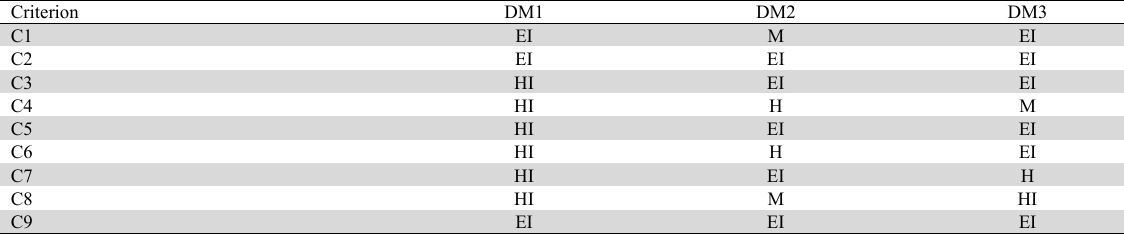
Ratings of criteria assessed by maritime decision-makers Criterion